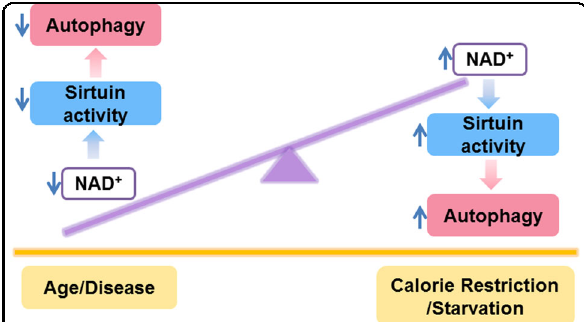
Fig. 2 A potential model for the connection between NAD + , sirtuins and autophagy. Nutrient limitation increases the level of the essential cellular metabolite NAD + , which activates sirtuins by inducing autophagy within cells and tissues. In contrast, the activity of sirtuins and autophagy decreases during normal aging, as well as due to some diseases 26 , and correlates with the known reduction in levels of tissue NAD